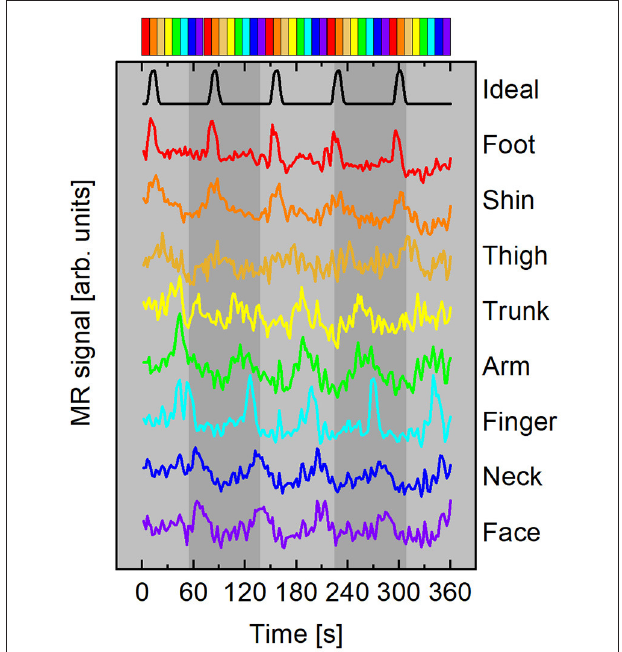
FIGURE 3 | Representative mean time courses (subject A) averaged from surface elements in ROI with ρ ≥ 0.45. Curves color-coded according to time delay, 1 t , with respect to the ideal time course (black curve). Time courses have been vertically offset for clarity. Top: Colorbar summarizing stimulus timing for the forward paradigm depicted in Figure 2